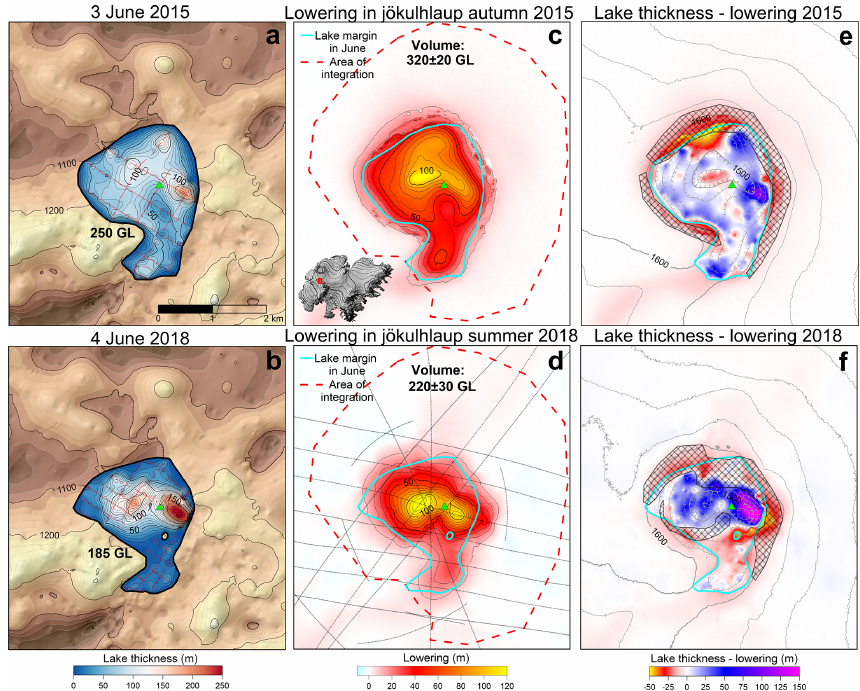
Figure 7. (a–b) The ESC lake thickness maps 4 and 2 months before the jökulhlaups in 2015 and 2018, respectively (from Fig. 6c and f). (c–d) Maps of glacier surface lowering during these jökulhlaups. The dashed red line indicates the area of integrated surface lowering cor- responding to the area of notable surface lowering during the 2015 jökulhlaup. The grey lines in panel (d) indicate the locations of radar altimetry profiles surveyed from an aeroplane on 9 August 2018, a week after the jökulhlaup. The total volume of the lake integrated from the lake thickness maps (a–b) and the released volume integrated from the surface lowering during jökulhlaup adding estimated volume of crevasses (c–d) are displayed in GL (10 6 m 3 ). (e–f) The difference between lake thickness obtained by RES, in 2015 and 2018, and the lower- ing during the following jökulhlaup. Polygons filled with diagonal crosses indicate the areas of large crevasses formed during the jökulhlaups as outlined from Fig. 1c–d. The contour maps indicate surface elevation (20m contour interval) from TanDEM-X on 10 October 2015 (e) and from the altimetry profiles on 9 August 2018 (f) as explained in Sect. 2.4. The green triangle in panels (a) – (f) indicates location of a GNSS station operating during both